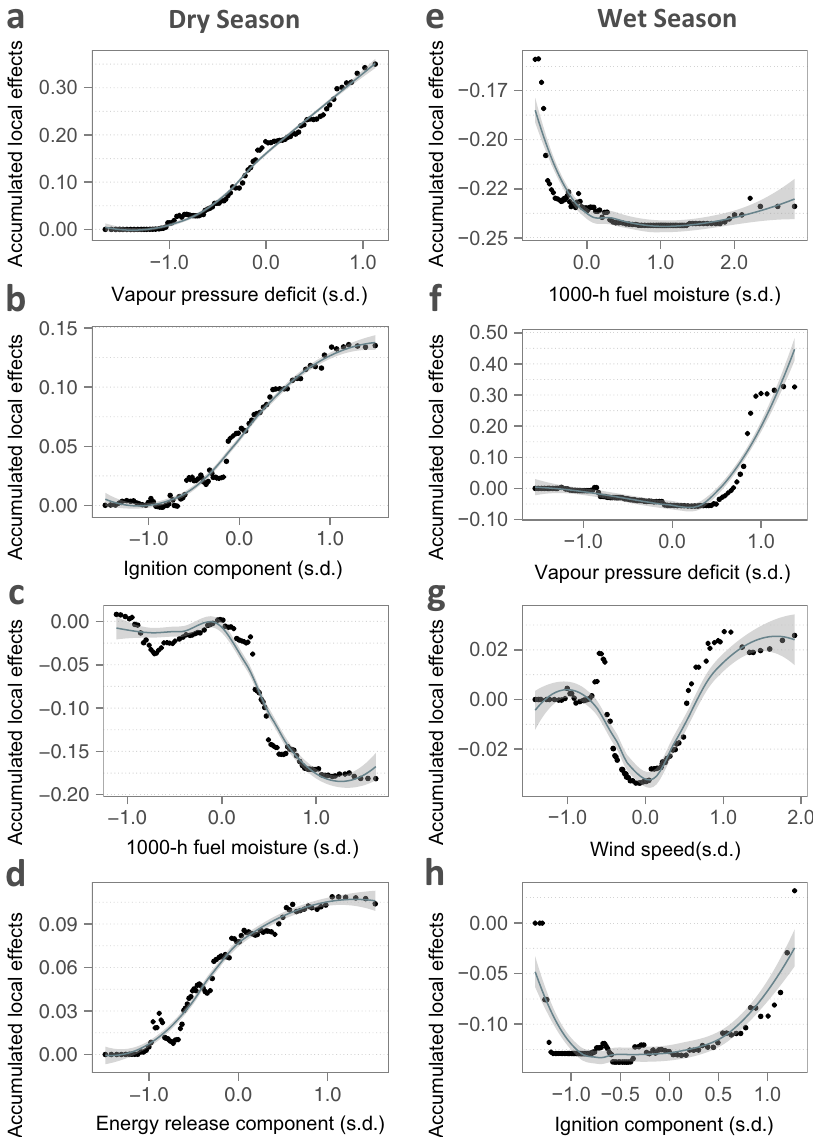
Fig. 2 Sensitivity of large fi re probability (LFP) to meteorological variables and fi re indices. Accumulated local effect (ALE) plots show the relationship between large fi re risk and the top four key drivers in dry ( a – d ) and wet ( e – h ) seasons. The x- axes represent the independent covariates (in units of standard deviation), and the y- axes represent the size of the mean effect each covariate has on large fi re probability (LFP). Variables are ranked in order of the relative importance in random forest models from high ( a , e ) to low ( d , h ). Grey lines refer to locally weighted smooth series with the 95% con fi dence intervals